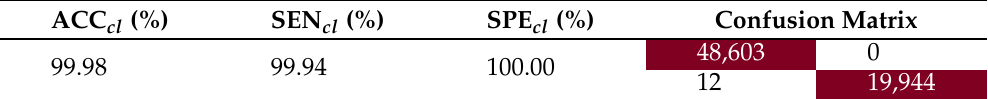
Table 9. Overall classification, where cl = Arrhythmia.